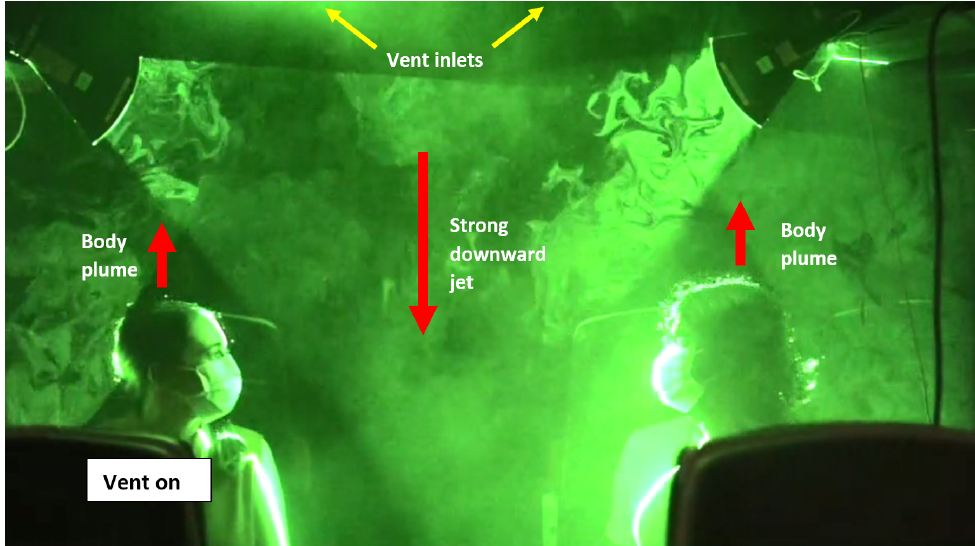
Figure 12. Snapshot of flow visualisation experiment at middle of carriage during ventilated condi- tions. Red arrows indicate direction of persistent air flow. Yellow lines indicate location of inlet and extract